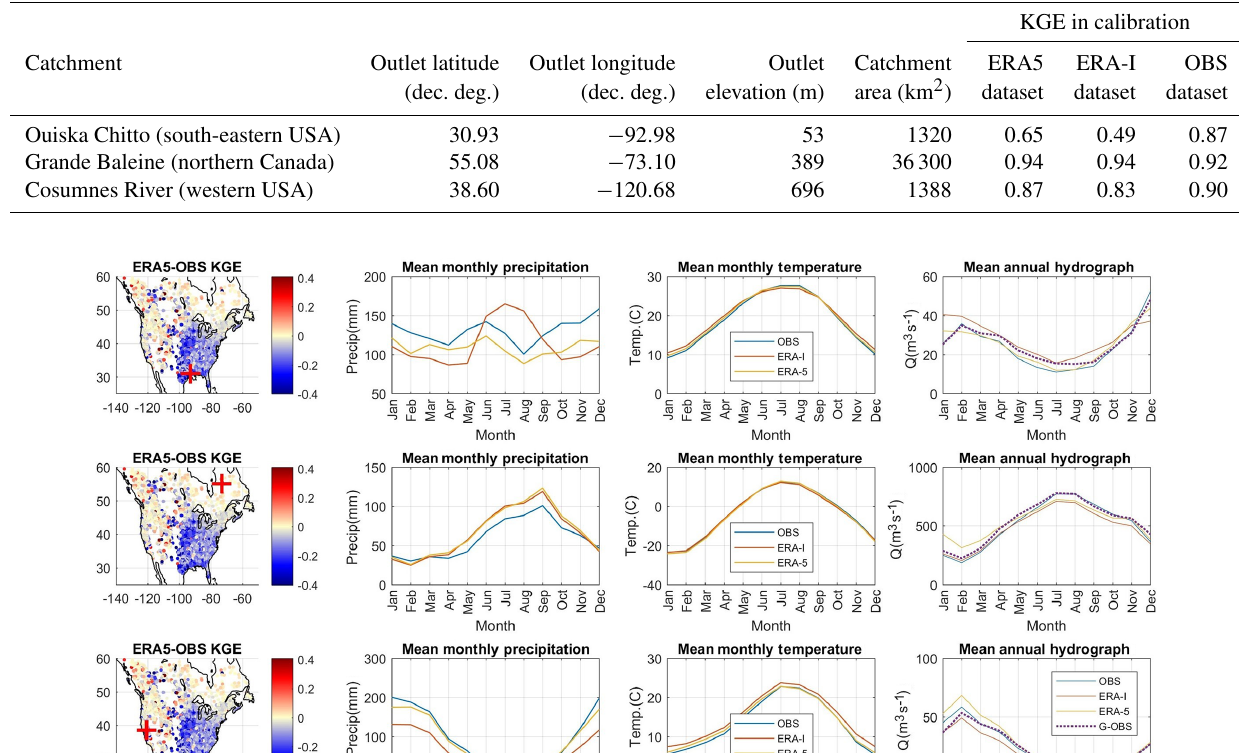
Table 1. Summary of physical and hydrological modelling statistics for the three catchments presented in Fig. 11.